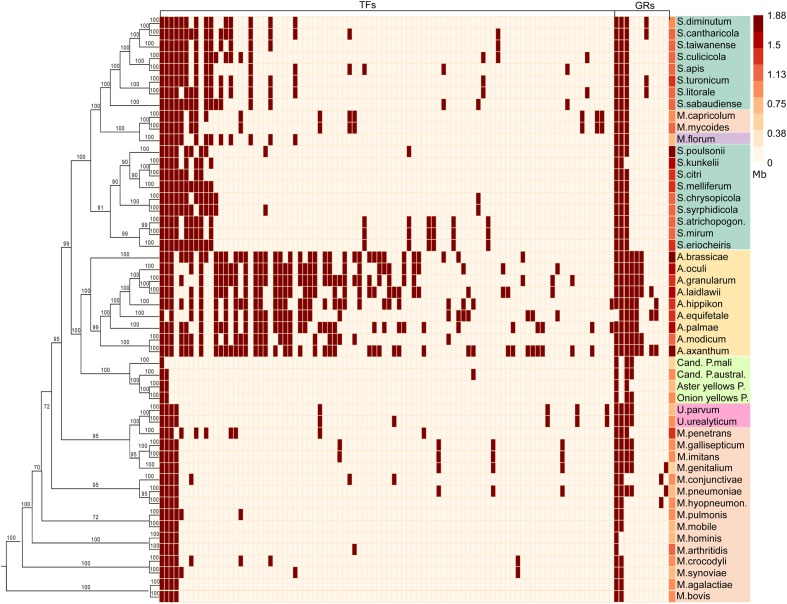
Regulators conservation in Mollicutes: distribution of transcription factors (TFs) and global regulators (GRs); the last column represents the genome size. Plot shows the presence (brown) or absence (white) of regulators conserved in at least two analyzed genomes. Phylogenetic tree was constructed based on alignments of orthologs conserved between all species. Background colors for species: yellow - Acholeplasma sp., aquamarine - Spiroplasma sp., orange - Mycoplasma sp., lime - Phytoplasma sp., violet - Mesoplasma florum, pink - Ureaplasma.